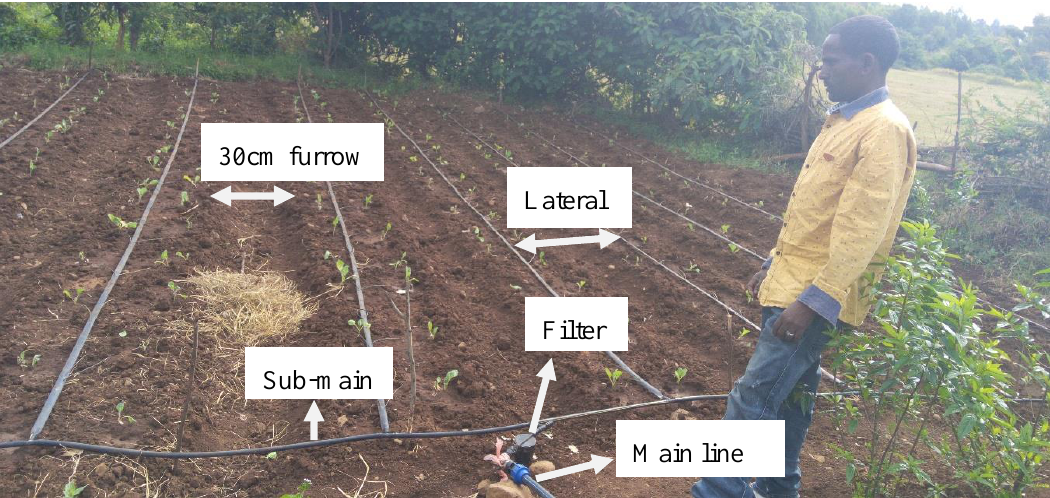
Figure 3. Layout of drip irrigation system (mains, submains, drip kits, and laterals including sand filter) with transplanted vegetables.